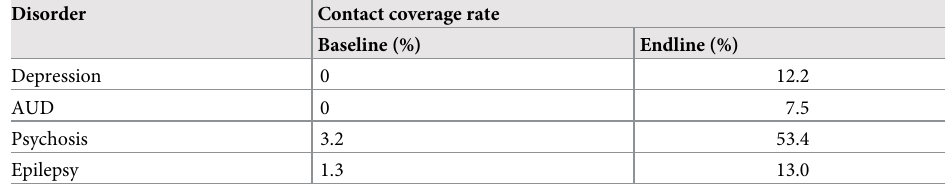
Table 5. Contact coverage rates for people with probable depression, AUD, psychosis, and epilepsy using 12-month service utilisation